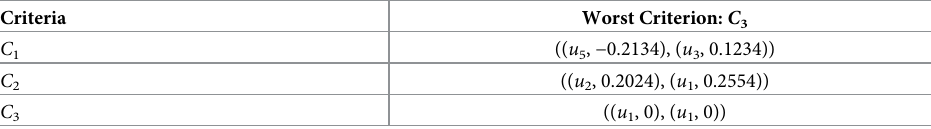
Table 4. Pairwise comparison vector for the worst criterion.